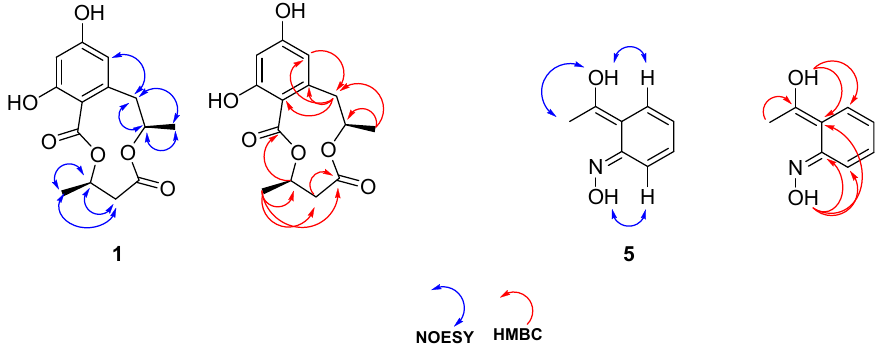
Figure 2. NOESY and HMBC correlations for talarodioxadione 1 and talarooxime 5. Talarooxime 5 was obtained as colorless crystals. The molecular formula of 5 was determined from the analysis of HR-ESI-MS and ID. The HR-ESI-MS positive mode showed an ion at m / z 152.07061 [M+H] + (calcd. for C 8 H 10 O 2 : 152.07115). The NMR experi- ments were performed in DMSO- d 6 to enable the detection of exchangeable protons. Two broad singles of the two hydroxyl groups appeared at δ H (ppm) 9.72 and 9.29, whereas the four aromatic protons resonated at δ H (ppm) 7.66 (dd), 6.93 (td), 6.84 (dd) and 6.75 (td). 1D-NOESY experiment helped assign the configuration of 5 . Clear NOESY correlations between the hydroxyl groups and the aromatic protons were observed, suggesting trans - conformation around the external double bonds (Figure 2). 13 C-NMR showed eight signals which were assigned from HSQC and HMBC experiments. Protonated carbons showed cross-couplings in the HSQC spectrum at δ c (ppm): H-3/C-3 (122.3), H-4/C-4 (118.9), H- 5/C-5 (124.6), H-6/C-6 (115.9) and H-8/C-8 (23.6). The designation of C-1, C-2 and C-7 were deduced from the HMBC spectrum at δ c (ppm) 147.8, 126.4 and 168.9, respectively, as the 1 H- 13 C correlations were detected from N-OH to C-1/C-2/C-6, from -CH 3 to C-7, and from C-OH to C-2/C-3. 3.2. Identification of Talaromyces Stipitatus Polyesters Biosynthetic Gene Cluster The polyesters isolated from T. stipitatus consist of 2,4-dihydroxy-6-(2-hydroxypro- pyl)benzoate and 3-hydroxybutyrate subunits, which were predicted to derive from an HR-PKS and NR-PKS homologous to Men1 and Men2. Indeed, protein Blast searches us- ing the amino acid sequence of Men1 against the T. stipitatus protein database revealed a highly homologous HR-PKS (XP_002488696) at the top hit with 59% identity and 73% similarity, which is over twice higher similarity than the second top hit. The Men2 query showed an NR-PKS (XP_002488697) that shares a significant similarity, with 67% identity and 80% similarity compared to the second top hit (Figure S12). Interestingly, the two corresponding genes of XP_002488696 and XP_002488697, which were named tpeA and tpeB, existed together in a gene cluster with a size of around 27.5 kb. The identified gene cluster also contains a cytochrome P450 oxygenase ( tpeC ) and a regulator protein ( tpeD ) (Figure 3). Figure 3. The putative biosynthetic gene cluster of the T. stipitatus polyesters encodes a highly re- ducing polyketide synthase (HR-PKS), a nonreducing polyketide synthase (NR-PKS), a cytochrome P450 oxygenase and a regulator protein.